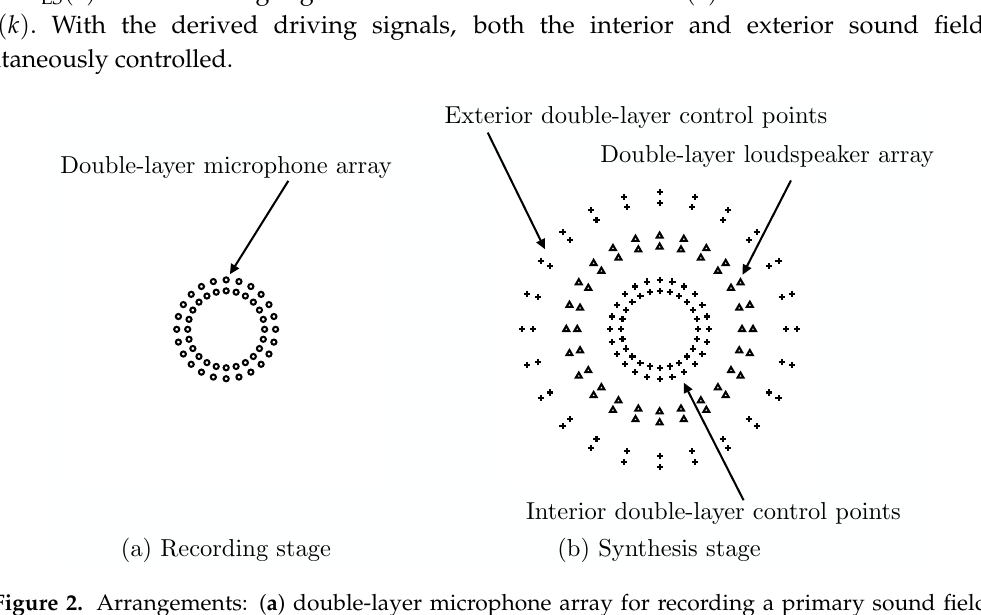
Figure 2. Arrangements: ( a ) double-layer microphone array for recording a primary sound field; and ( b ) double-layer arrays of loudspeakers and control points for synthesizing recorded primary sound field at a secondary